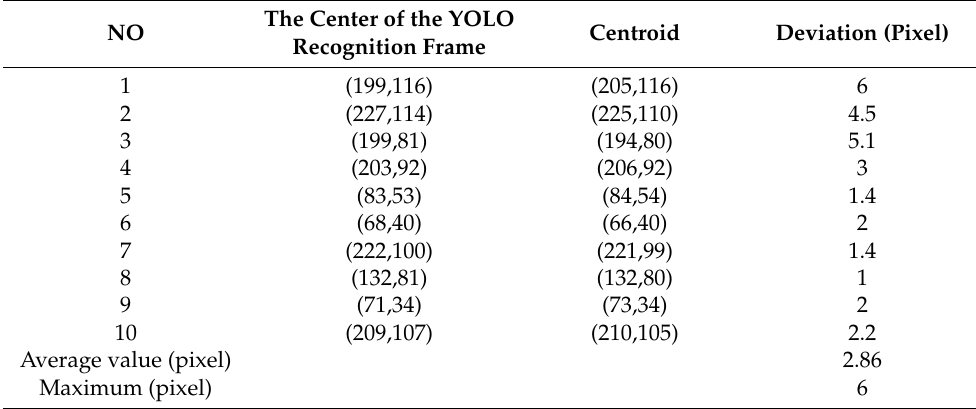
Table 2. Positioning